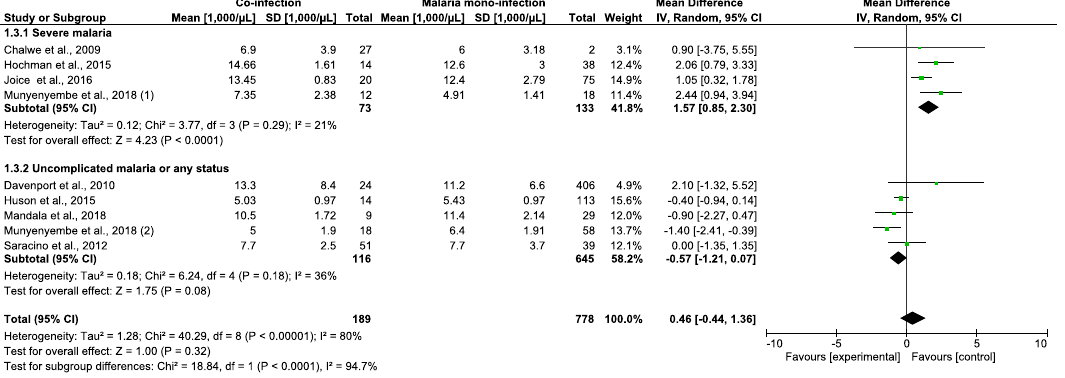
Figure 5. The pooled MD of total leukocyte between Plasmodium spp. and HIV co-infected and Plasmodium spp. patients.